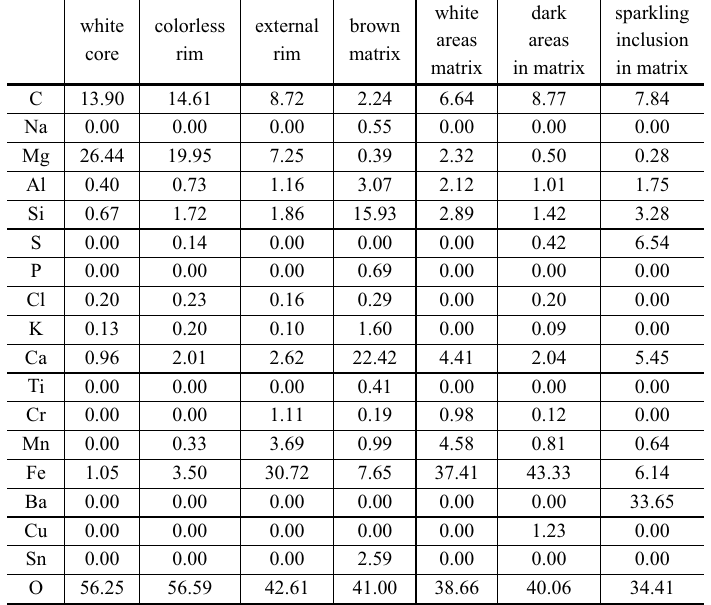
Chemical analyses performed in the ESEM by EDS on the slag sample number 2 (shown in Fig. 4).